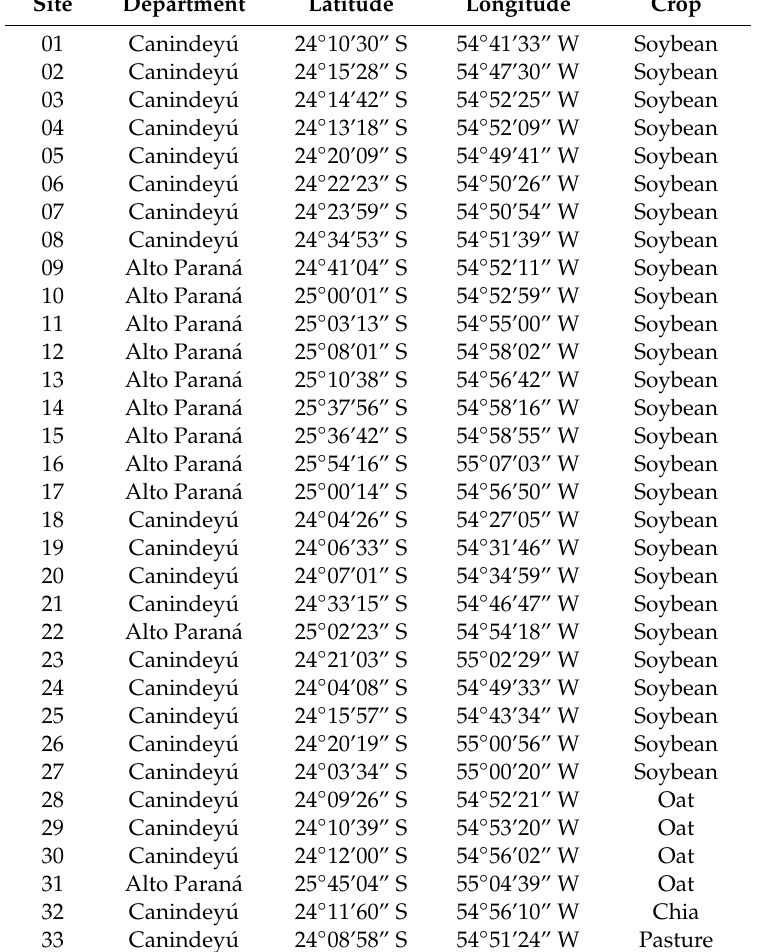
Table 1. Collection sites of Conyza sumatrensis populations with suspected resistance to herbicides. Canindey ú and Alto Paran á , Paraguay, 2017 / 18 and 2018 / 19